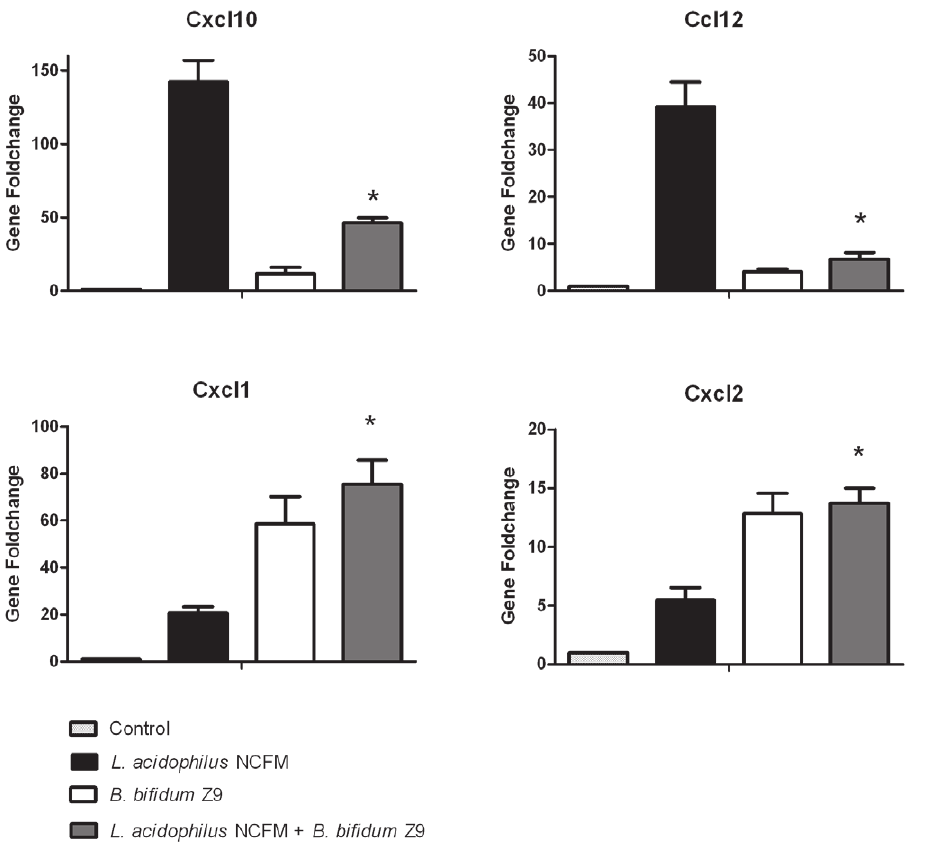
Figure 3. Induction of chemokines in Lactobacillusacidophilus NCFM and Bifidobacteriumbifidum Z9 stimulated dendritic cells. Gene expression analysis of the chemokines Cxcl10 , Ccl12 , Cxcl1 and Cxcl2 in dendritic cells upon stimulation with L. acidophilus NCFM, B. bifidum Z9 or the two bacteria in combination and unstimulated dendritic cells (control) was performed by RT-PCR after 10 h of stimulation ( L. acidophilus NCFM + B. bifidum Z9 versus L. acidophilus NCFM, P ,